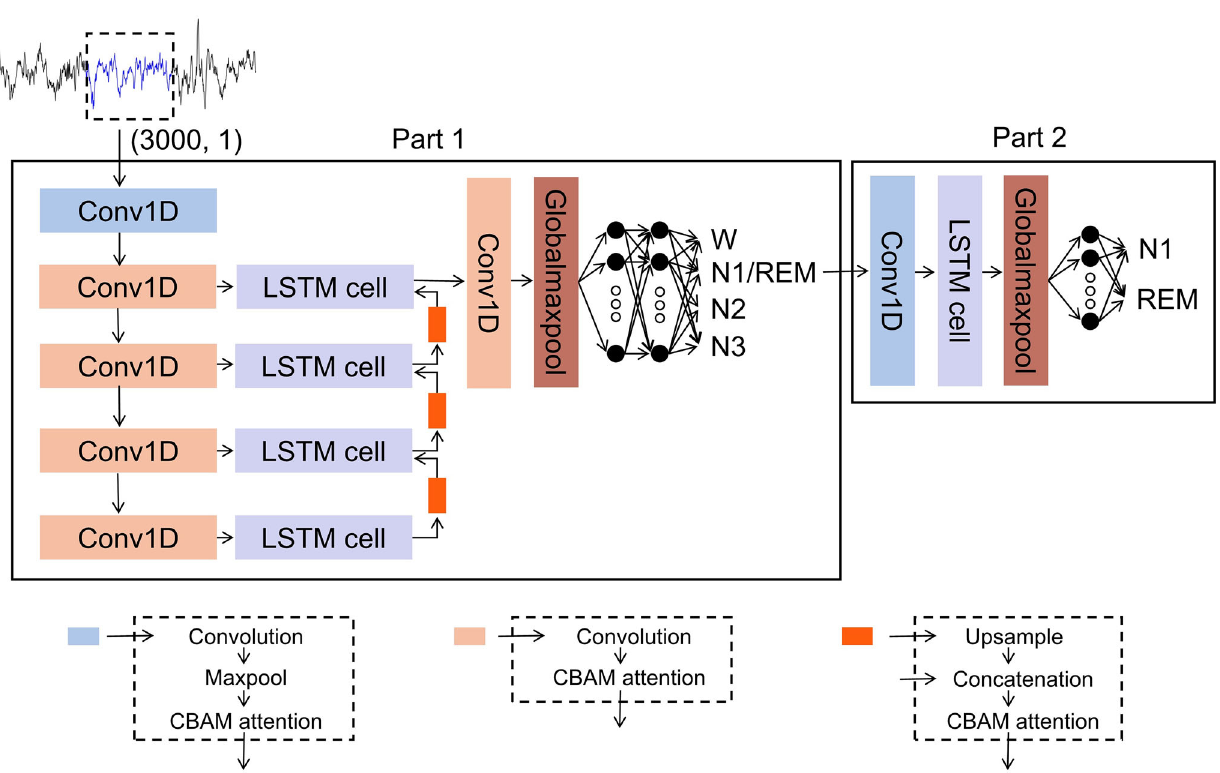
Fig. 2 Framework of the feature relearning method